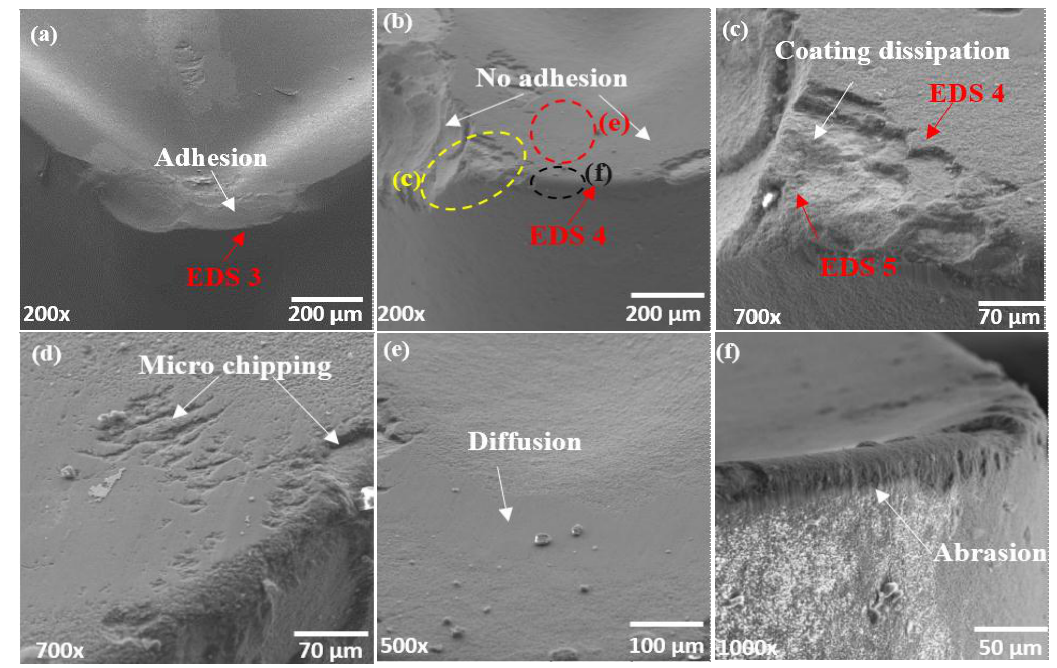
Figure 8. SEM images of CVD TiCN + Al 2 O 3 coated insert after machining SDSS: ( a ) cutting tool before etching; ( b ) cutting tool after etching; ( c – f ) cutting tool with different magnifications.